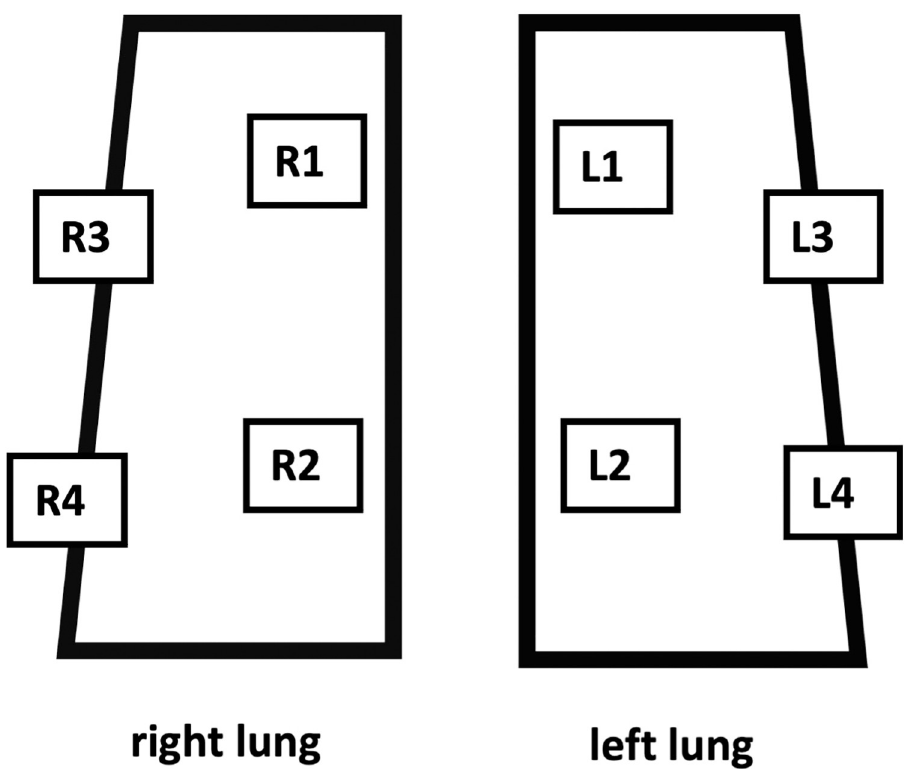
Fig 1. 8 zones (R1-R4, L1-L4) for LUS, adapted from CLUE protocol [12].